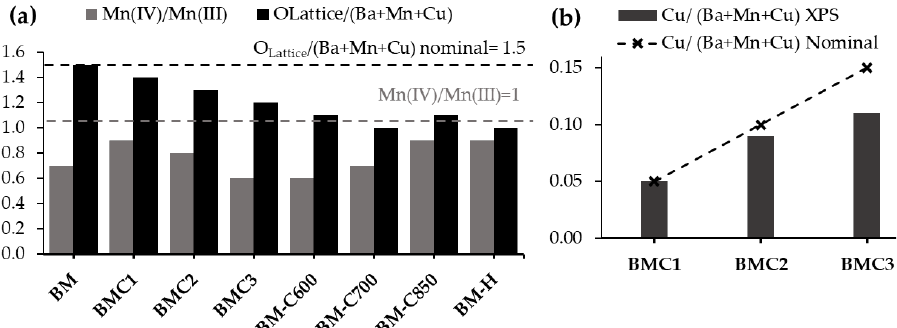
Figure 3. XPS ratios ( a ) Mn (IV)/Mn (III) and O Lattice /(Ba + Mn + Cu) and ( b ) Cu/(Ba + Mn + Cu) for the BaMn 1 − x Cu x O 3 and BaMnO 3 catalyst